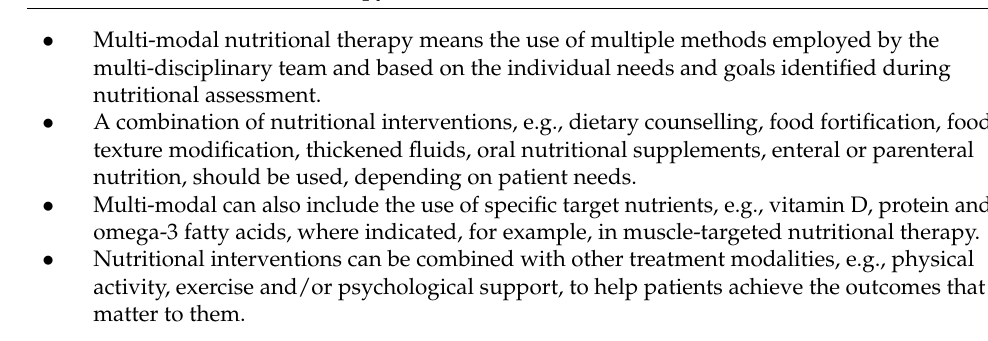
Table 2. Multi-modal nutritional therapy. Multi-Modal Nutritional Therapy